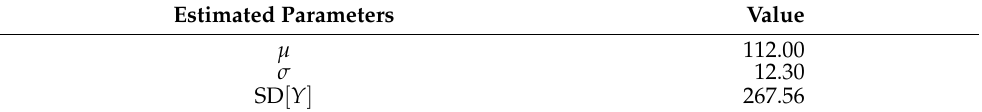
Table 13. Estimated parameters of the WEI3 distribution with monthly drug DPUT